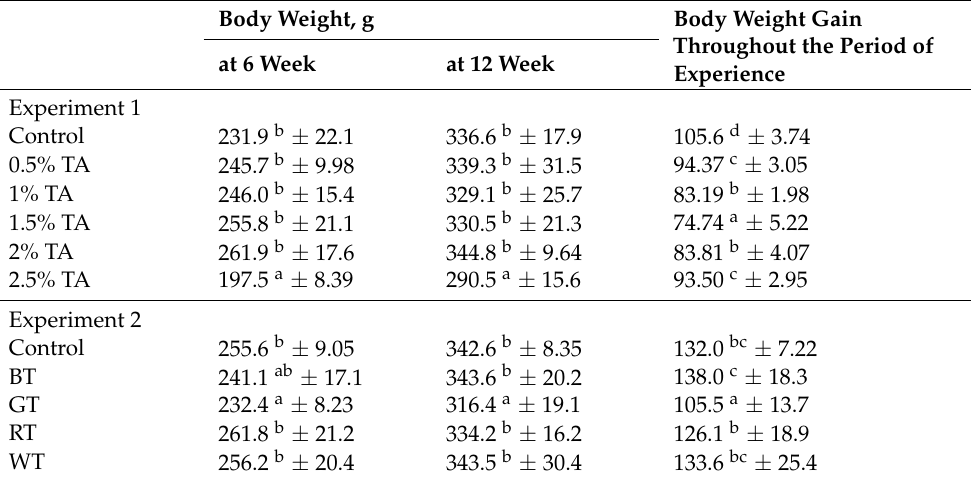
Table 3. Mean body weight of rats at 6 and 12 weeks of exposure (mean ±